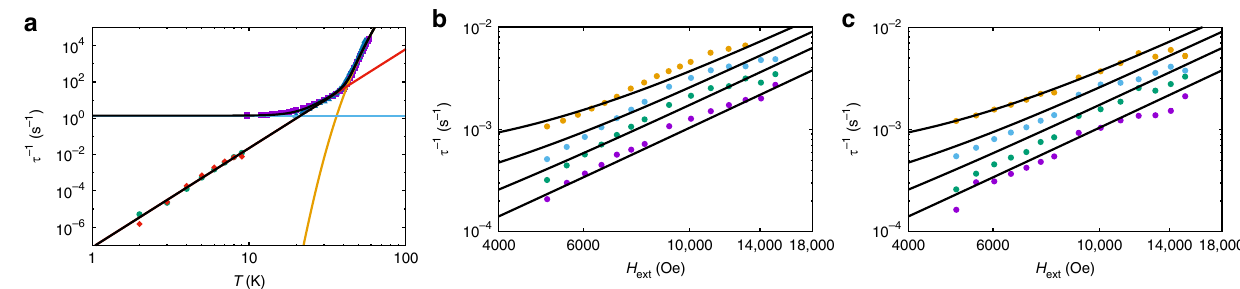
Fig. 4 Low temperature and high fi eld magnetic relaxation. a Magnetic relaxation rate measured by AC magnetometry for 1 (purple squares) and 1a (blue triangles) and DC magnetometry for 1 (green circles) and 1a (red diamonds; note the log-log scale); DC points chosen as the slowest relaxation rates at each temperature for each sample. Black lines are a fi t with Eq. (1) using the parameters: U eff = 950(20) K, τ 0 = 3(1) × 10 − 12 s, C = 7.8(8) × 10 − 8 s − 1 K − n , n = 5.46(4), τ − 1 QTM = 1.4(1) s − 1 ( τ − 1 QTM = 0 for AC data of 1a and all DC data) and D = 0 ( fi xed), orange line is the Orbach component alone, red line is the Raman component alone, blue line is the QTM component alone (only applicable for AC data of 1 ). Note the two different relaxation rates for 1 at ~10 K: the AC data are collected in zero DC fi eld where QTM is operable ( τ − 1 QTM ≠ 0) while for the DC data we assume QTM to be effectively quenched ( τ − 1 QTM = 0). b , c Magnetic relaxation rate measured by DC magnetometry (note the log – log scale) for 1 ( b ) and for 1a ( c ) at 2 (purple circles), 3 (green circles), 4 (light blue circles) and 5 K (orange circles). Black lines are fi ts with Eq. (1) using the parameters given for Fig. 5a, however with D = 7(3) × 10 − 13 s − 1 Oe − m K − l , m = 2.20(5) and l = 1.23(5). Error bars for the DC data are within the data points